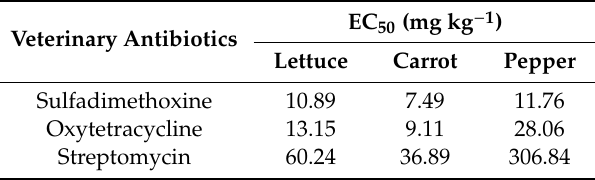
Table 2. Toxicity data from seed germination tests for lettuce, carrot, and pepper (filter paper test).